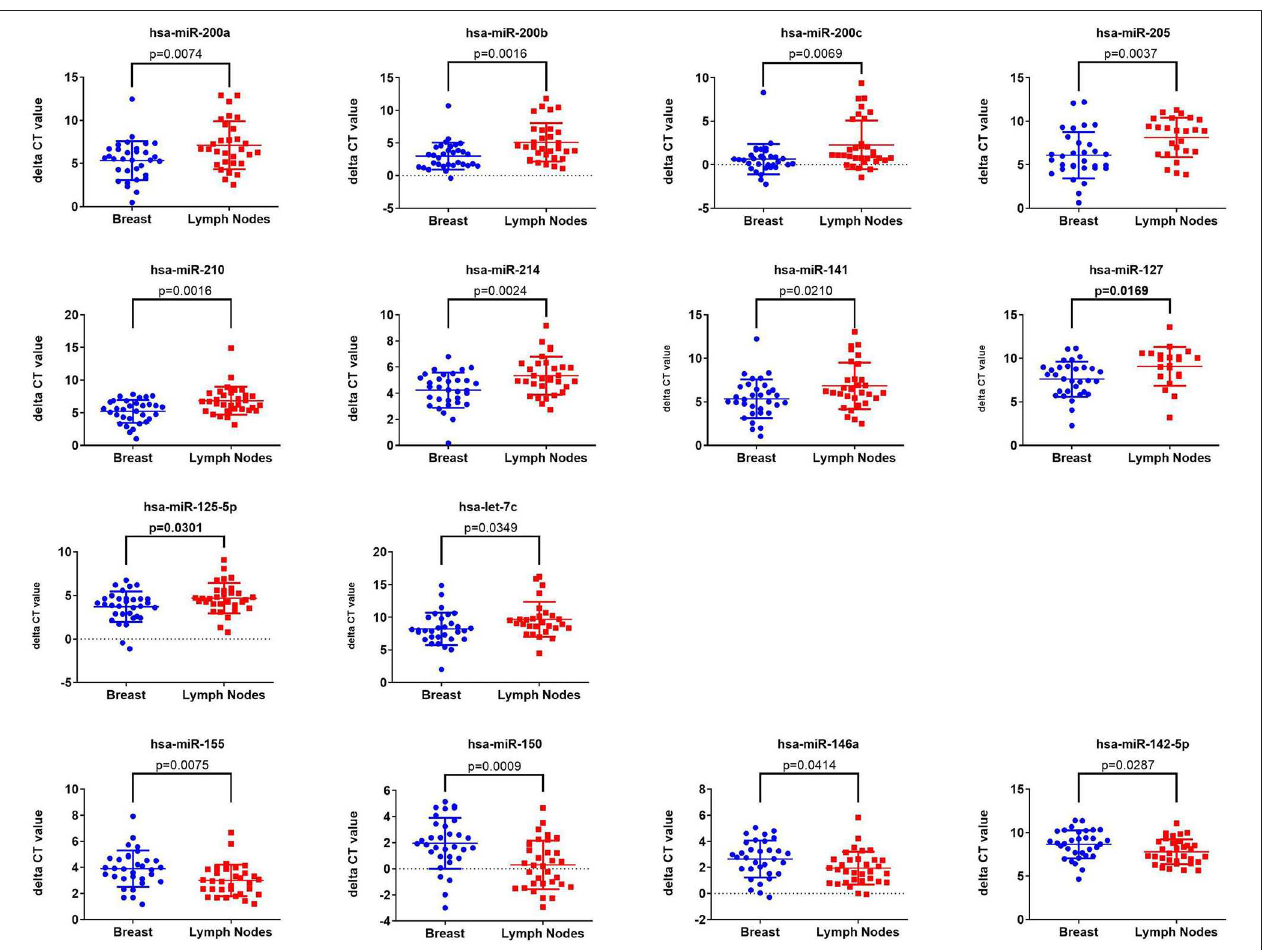
FIGURE 2 | Validation of the expression of 14 miRNAs identified from microarray data in a second cohort of 32 LNM and 32 matched primary BC tissue Taqman low density array (TLDA) qRT-PCR. P -values were calculated using two-tailed t -test and are indicated on each plot. Data are presented as “delta CT” using dot plots.